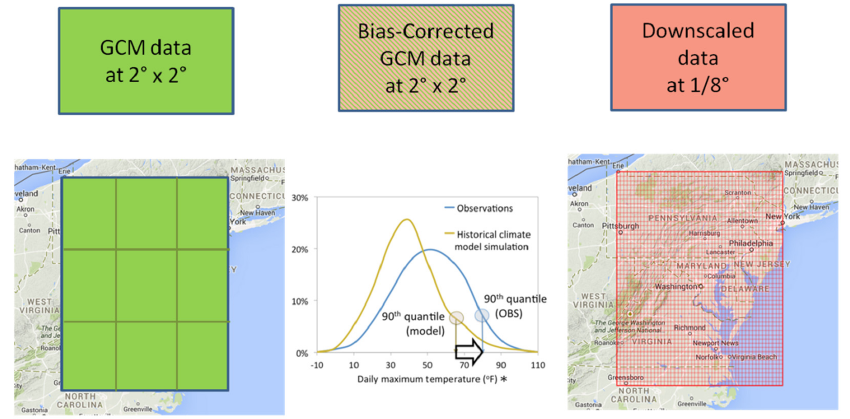
Figure 1. Chain of BCCA based temperature projections used in the study.Notes: * source is adapted from [41].